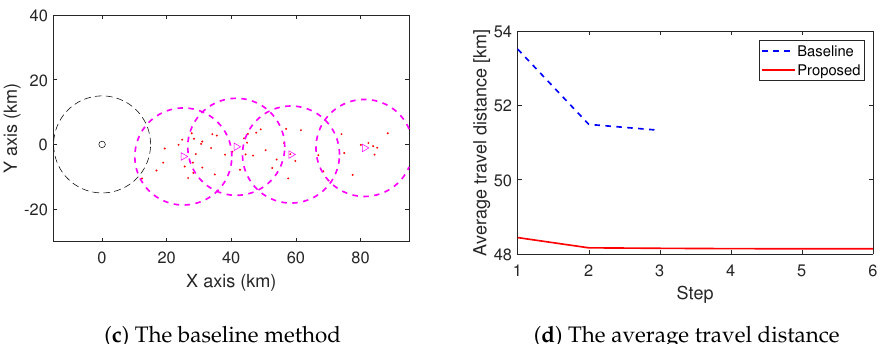
Figure 7. Comparison of the proposed method and baseline method in the case with four charging stations. The sites are represented by red dots.